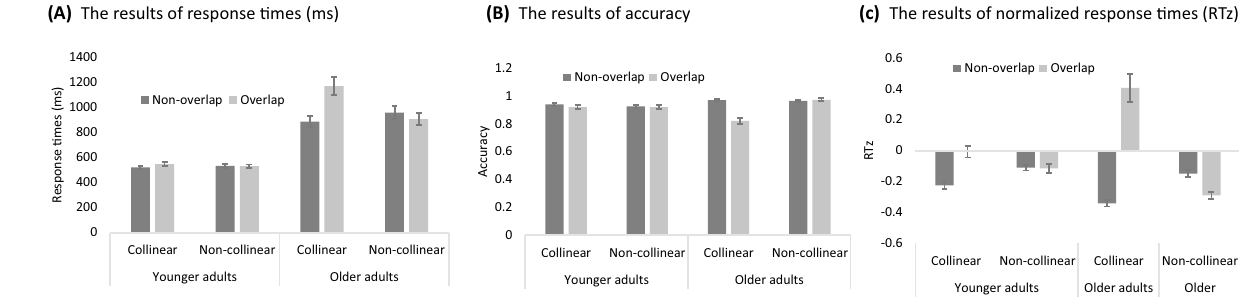
Figure 3. Results of Experiment 1: Reaction times of younger and older adults under collinear and non- collinear conditions. Error bars represent the standard error of the mean.